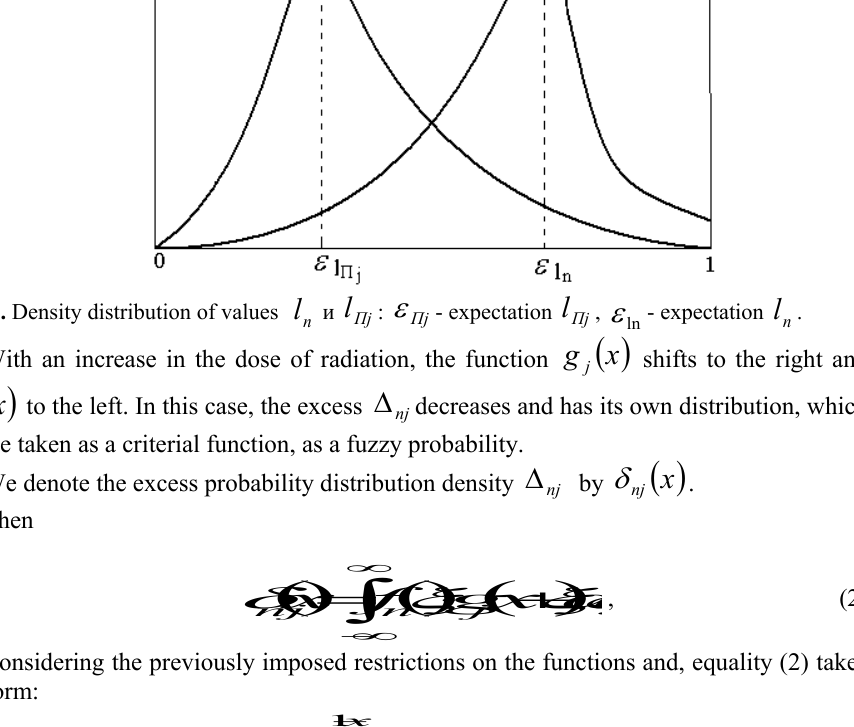
l :  - expectation l и Пj Пj n